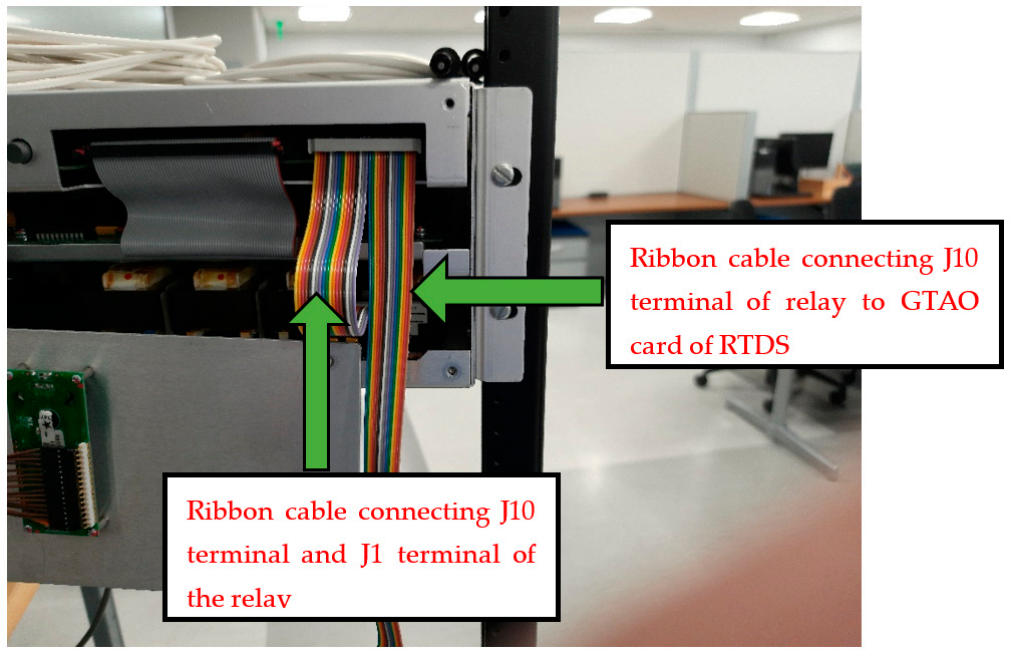
Figure 13. Connection on the relay end between relay and GTAO card.